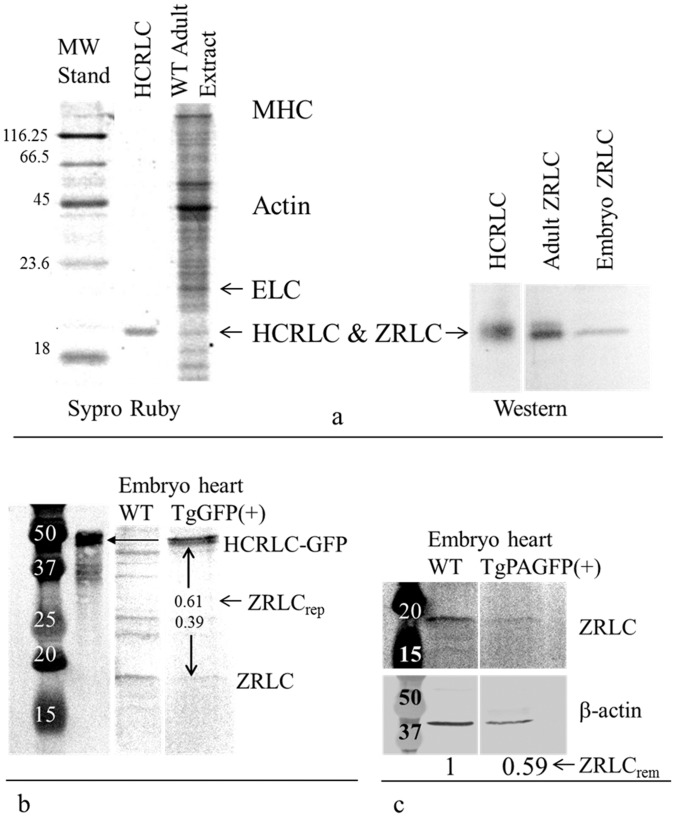
The Sypro Ruby stained and immunoblotted SDS-PAGE gels.The Sypro Ruby gel band intensities establish ZRLC content in a zebrafish adult heart extract relative to a known amount of in vitro expressed HCRLC (panel a). These samples produce calibrated blot intensities for HCRLC and ZRLC under a standardized protein immunoblotting protocol using the RLC antibody as described in Methods and previously [11]. The standards are compared to immunoblots from HCRLC-GFP and ZRLC in WT and TgGFP(+) embryos (panel b) to measure relative fractions of HCRLC-GFP and ZRLC content (ZRLCrep, Eq 1). The relative amount of ZRLC in WT and TgGFP(+) embryo hearts confirmed ZRLC content removed (ZRLCrem, Eq 2) by their comparison to control β-actin expression (panel c).